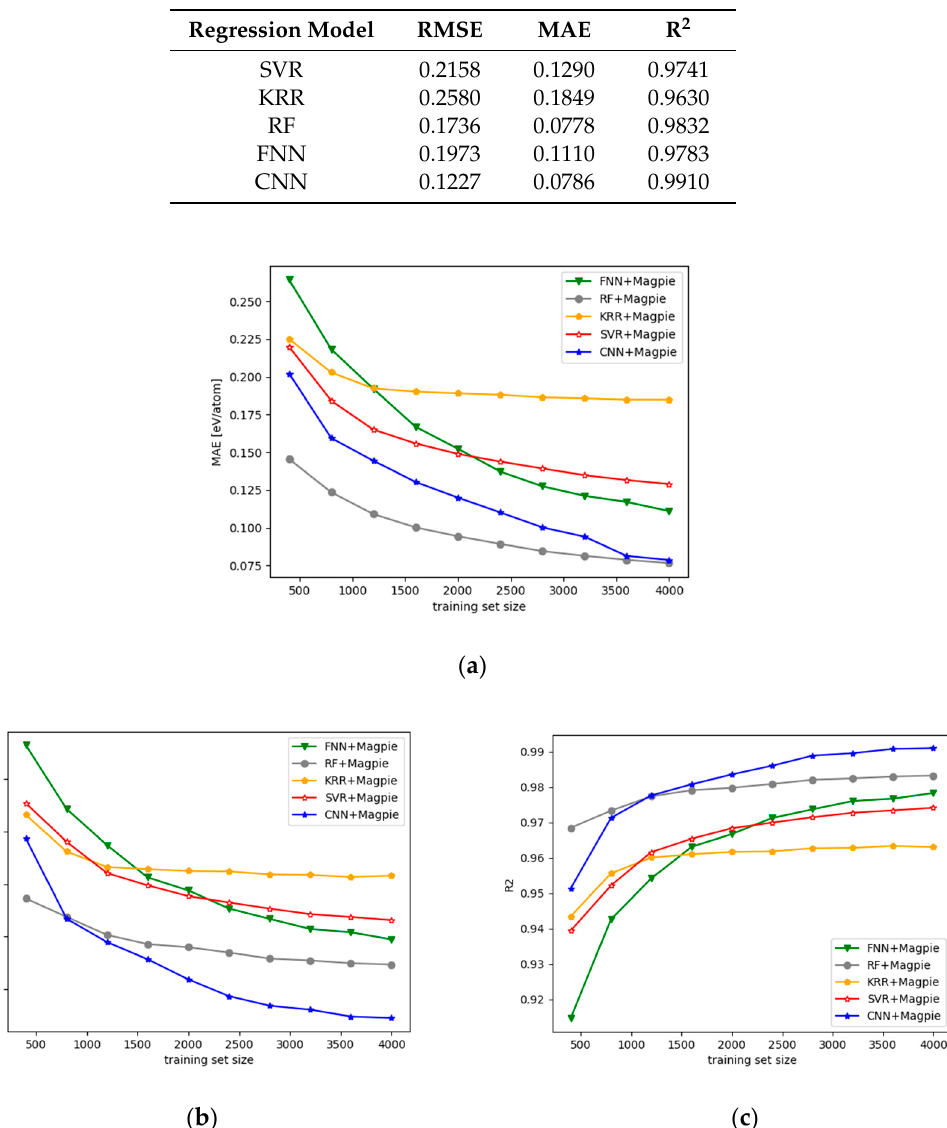
Table 2. RMSE (eV / atom), MAE (eV / atom) and R 2 values of cross-validation results for each prediction model using Magpie descriptors.